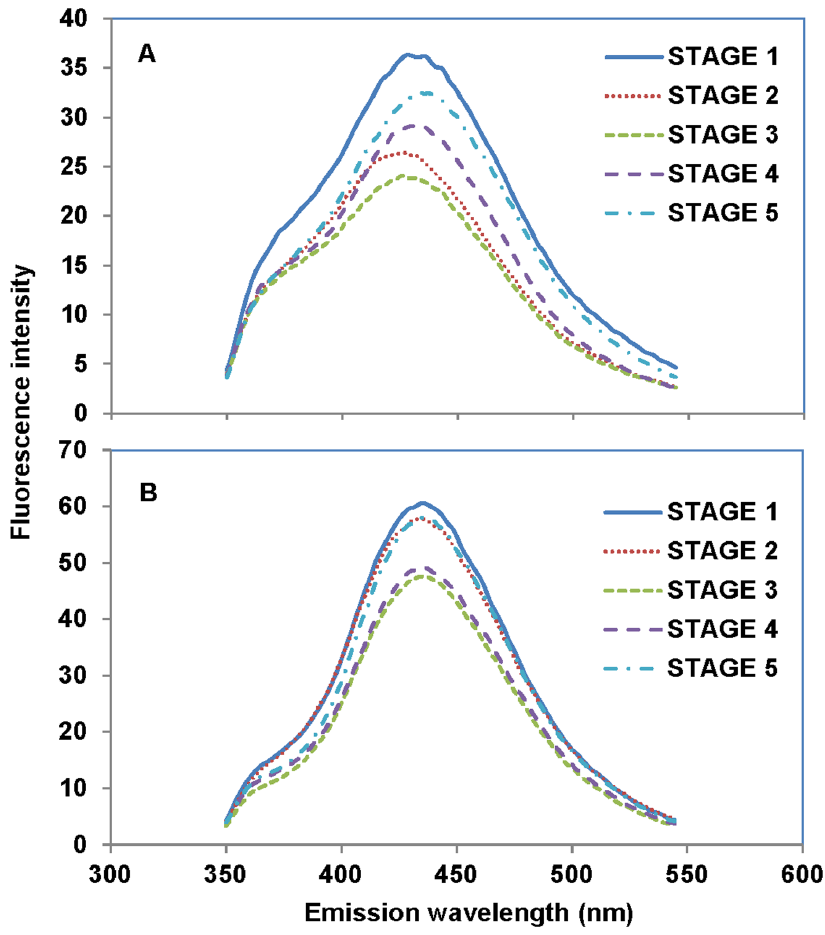
Figure 5. Generation of the hydroxyl radical ( . OH) in the extracts of the pod walls. . OH of P. sativum and B. chinensis was detected throughout the five developmental stages. The peak values of P. sativum were 36.2 6 4.0, 26.1 6 3.4, 23.8 6 2.1, 29.1 6 2.7, 32.1 6 3.0 during pod development from stages 1 to 5. And the peak values of were B. chinensis 57.8 6 4.9, 57.6 6 4.2, 47.1 6 3.9, 48.6 6 2.8, 57.0 6 3.6 mm from developmental stages 1 to 5. A sample was collected from both species during each stage of pod development; these samples consisted of five to eight pods, and each pod was separately collected from a different plant. Levels of.OH are expressed as relative fluorescence intensity and were measured using terephthalic acid (TPA) as a hydroxyl radical dosimeter. A: P. sativum ; B: B. chinensis .